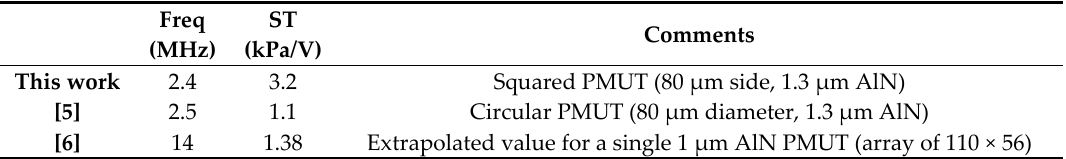
Table 1. Comparison Performance of the PMUT in FC-70 as